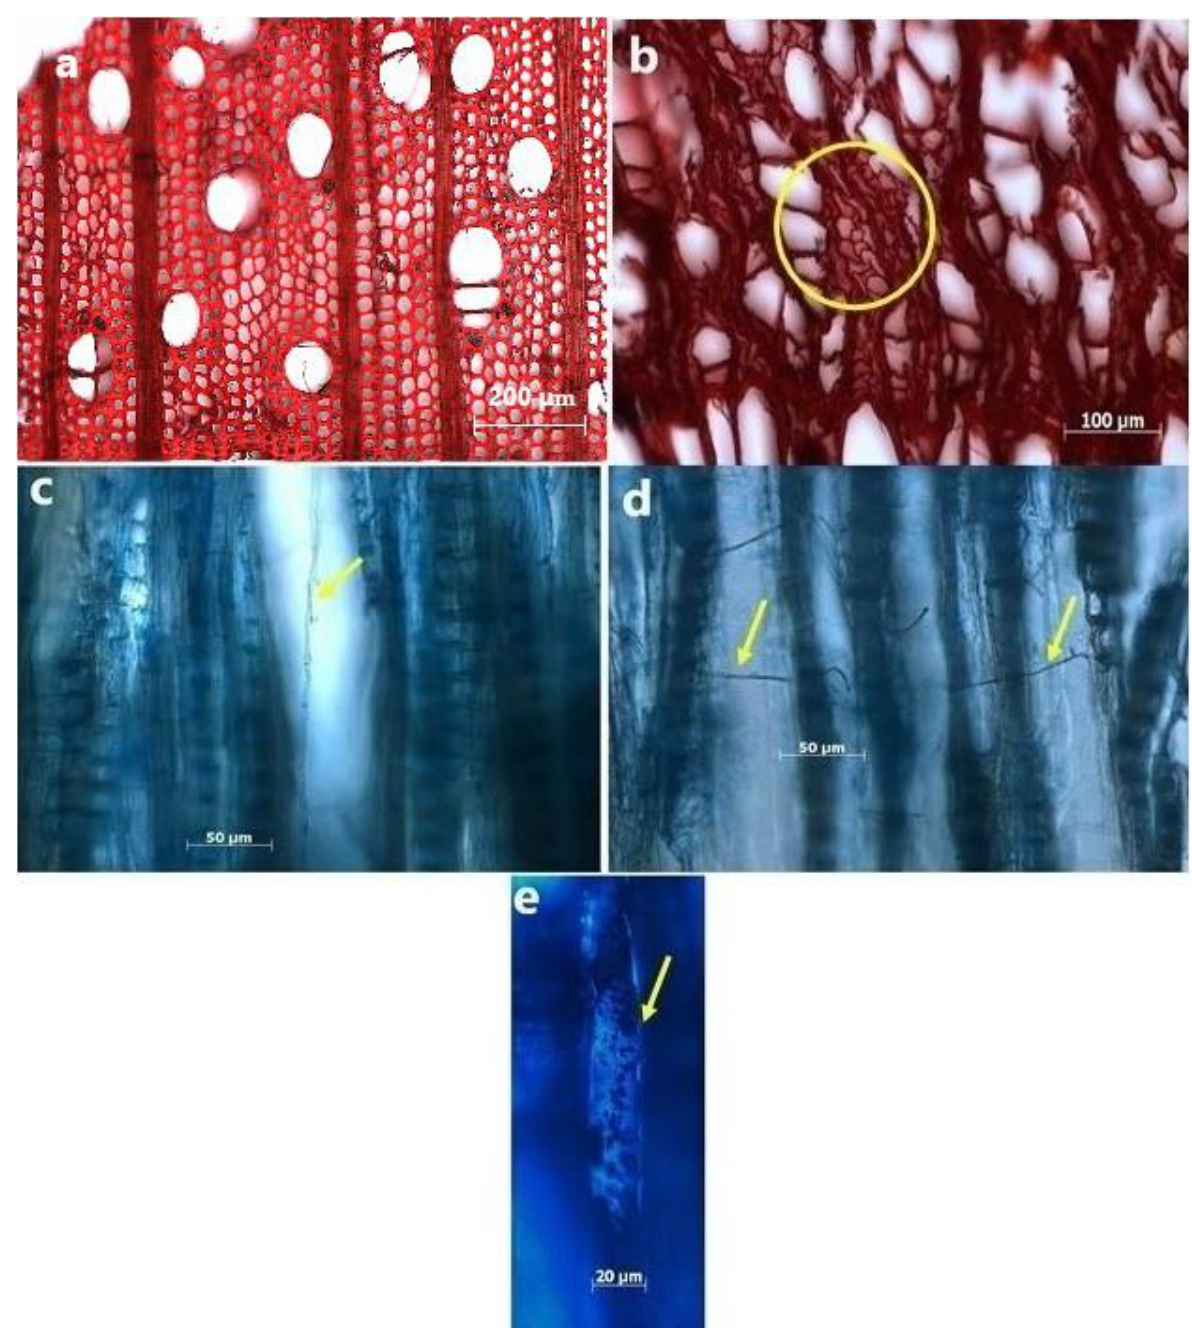
Figure 4. Light microscopy of cross-sections of recently cut ( a ) and archaeological poplar ( b ) and from tangential section of archaeological elm using polarized light ( c – e ). Arrows indicate the fungal hyphae ( c , d ) and bacterial degradation patterns ( e ) of archaeological wood samples.